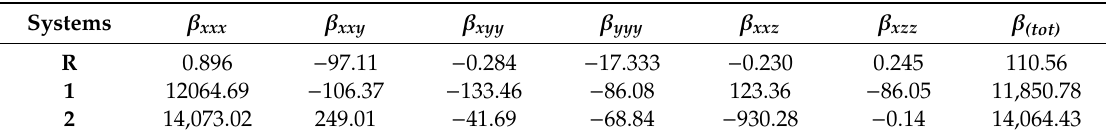
Table 5. Computed first hyperpolarizability ( β tot ) and major contributing tensor (a.u.) of R and 1 – 6 in the gas phase at the B3LYP / 6-31G(d,p) level of theory.